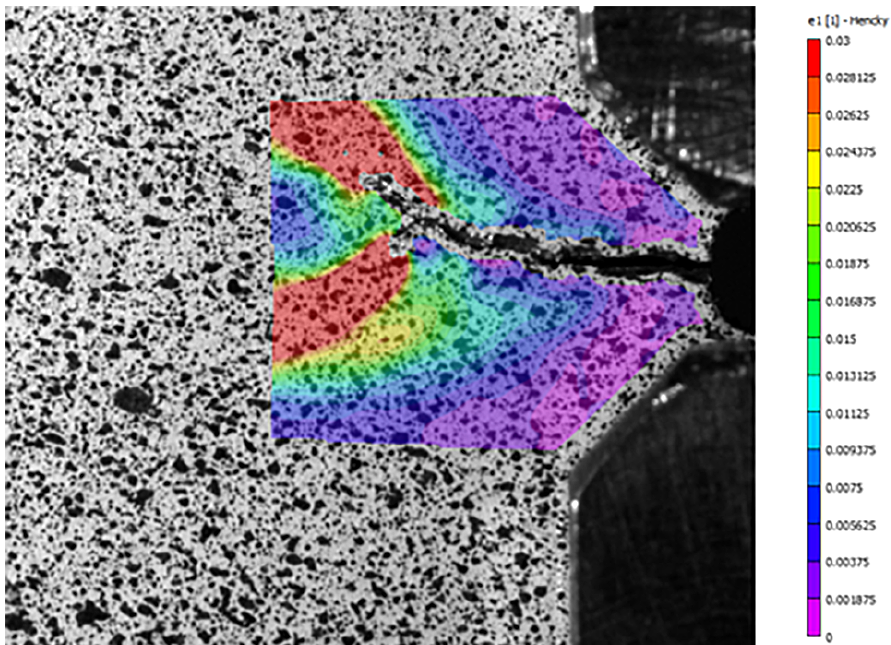
Figure 3. Strain field reported by the DIC system during cyclic loading of a CT specimen.